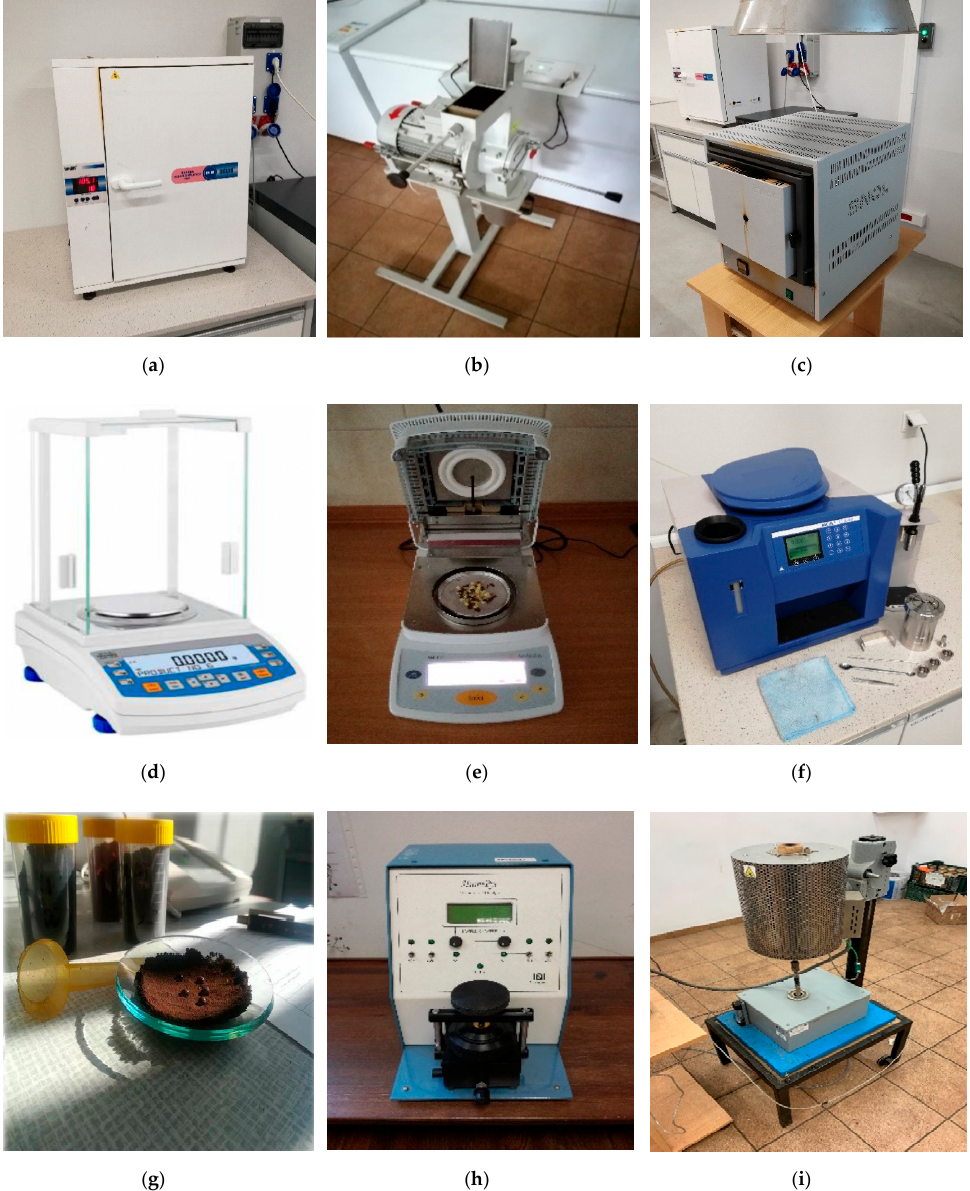
Figure 3. Laboratory devices: ( a ) drying chamber KBC-65W; ( b ) biomass mill LMN 400; ( c ) muffle furnace SNOL82/1100; ( d ) scale RADWAG AS 220.R2; ( e ) moisture analyzer SARTORIUS MA150; ( f ) calorimetric bomb IKA C200; ( g ) a set for WDPT (water drop penetration time) test; ( h ) gas pycnometer HumicPyc; and ( i ) thermogravimetric analyzer. The torrefaction temperatures were 200 °C, 220 °C, 240 °C, 260 °C, 280 °C, 300 °C and 320 °C. Carbon dioxide (to maintain the inert atmosphere) from the gas cylinder was used in the reactor chamber (90 mL ⋅ min − 1 ). The duration time of the torrefaction process was 60 min. The proposed thermal processing of forestry biomass, its basic properties, and process conditions are shown in Figure 4.